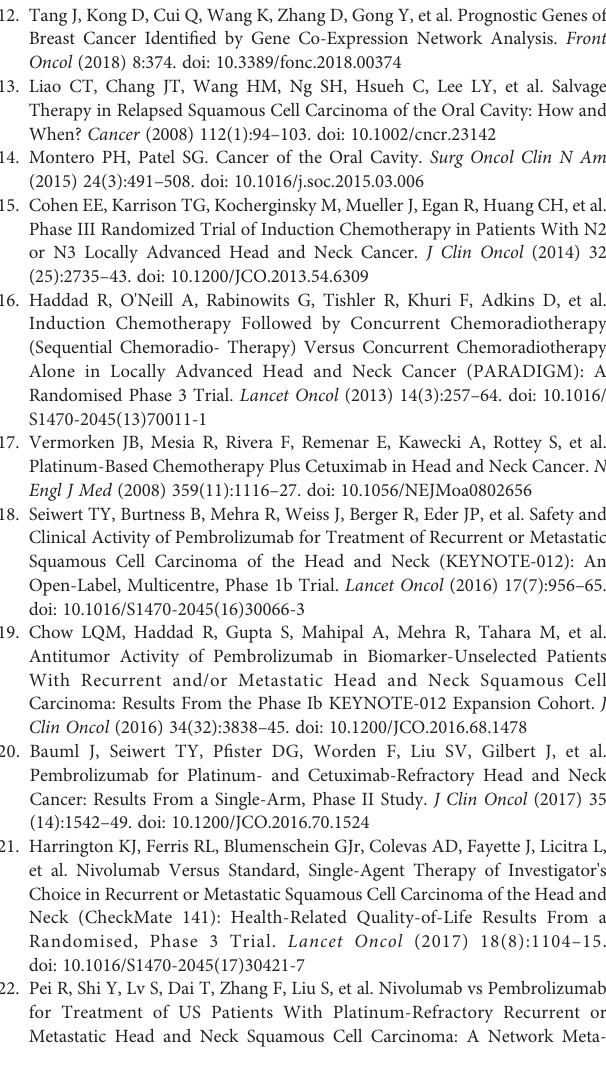
Supplementary Table 6 | The Coef fi cient of risk model based on the Lasso Cox